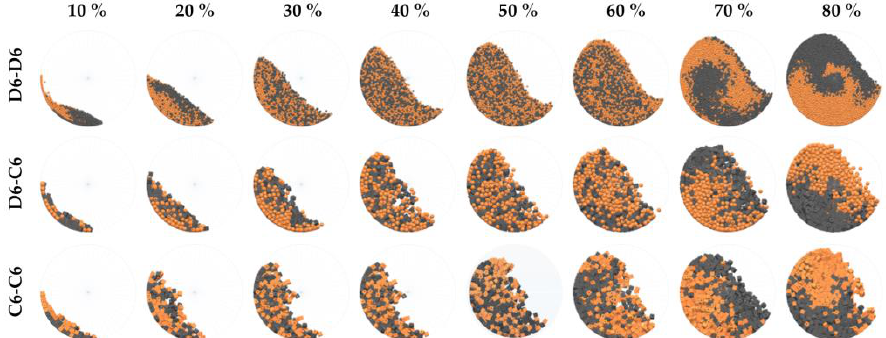
Figure 18. Influence of the degree of drum filling to the resulting homogeneity index after five